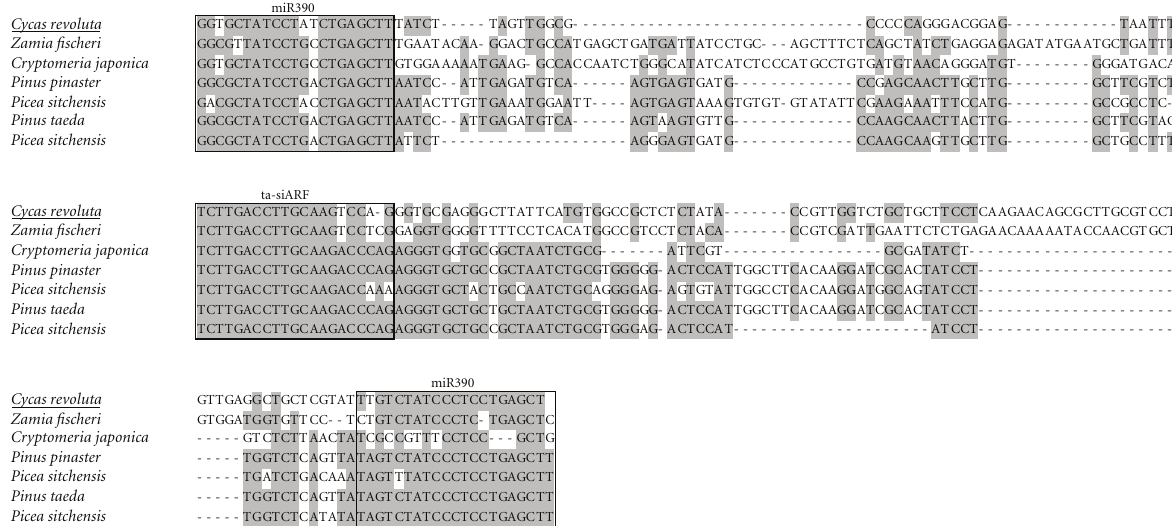
Figure 4: Nucleotide sequence alignment of “short” ta-siARF loci of cycad and conifer plants. The sequence of Cycas revoluta (undelined) was determined in this study, the others were taken from GeneBank. Boxes indicate miR390 complementary sites and ta-siARF sequence regions. Shading shows residues identical for the given position in most sequences. Sequences of C. revoluta miR390 complementary sites originate from primers used for the amplification of ta-siARF loci. GeneBank accession numbers of the sequences included in the alignment are as follows: Cycas revoluta , FJ804750; Picea sitchensis , EF086492; Pinus pinaster , BX682439; Pinus taeda , CV034496; Picea sitchensis , CO220369; Zamia fischeri , DY034932; Cryptomeria japonica ,